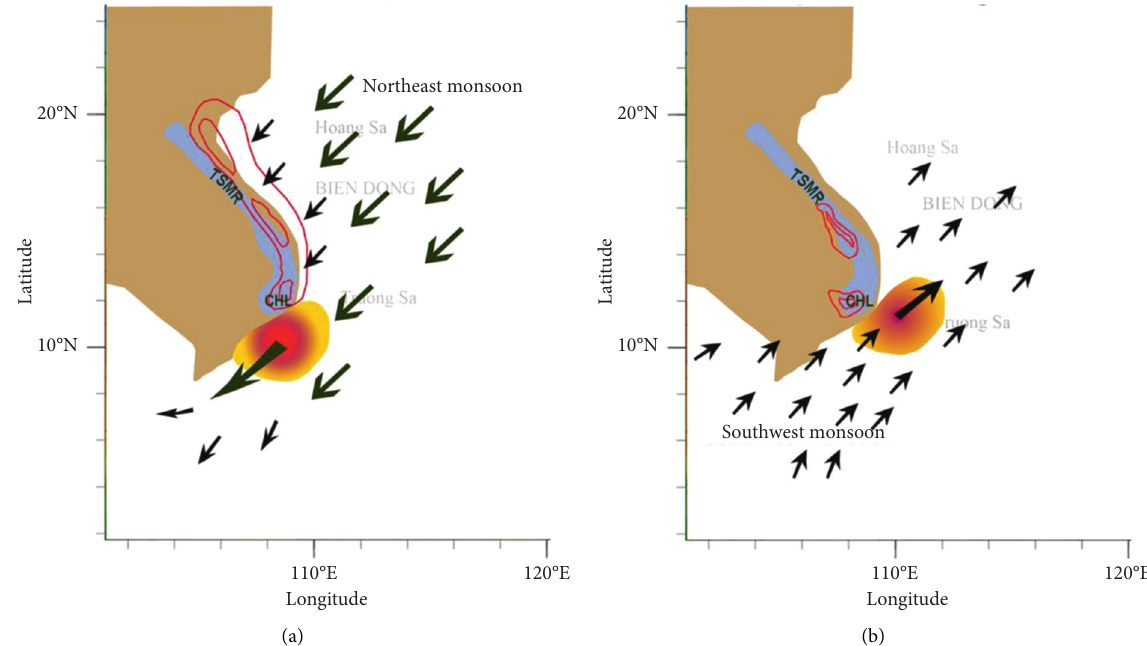
Figure 14: Schematic diagram of monsoon-land-ocean interaction and its effects on wind speeds over SV region for (a) winter regime and (b) summer regime. The yellow color indicates landmass. The dark-green color denotes Truong Son Mountain Range (TSMR) and Central Highlands (CHL). Red contours are pressure anomalies due to the orographic blocking effect. Black wind vectors for each wind regime with the maximum wind speed denote by the largest vectors. The color shading regions are local maximum wind speed location due to the funnel effect as a result of monsoon-land-sea